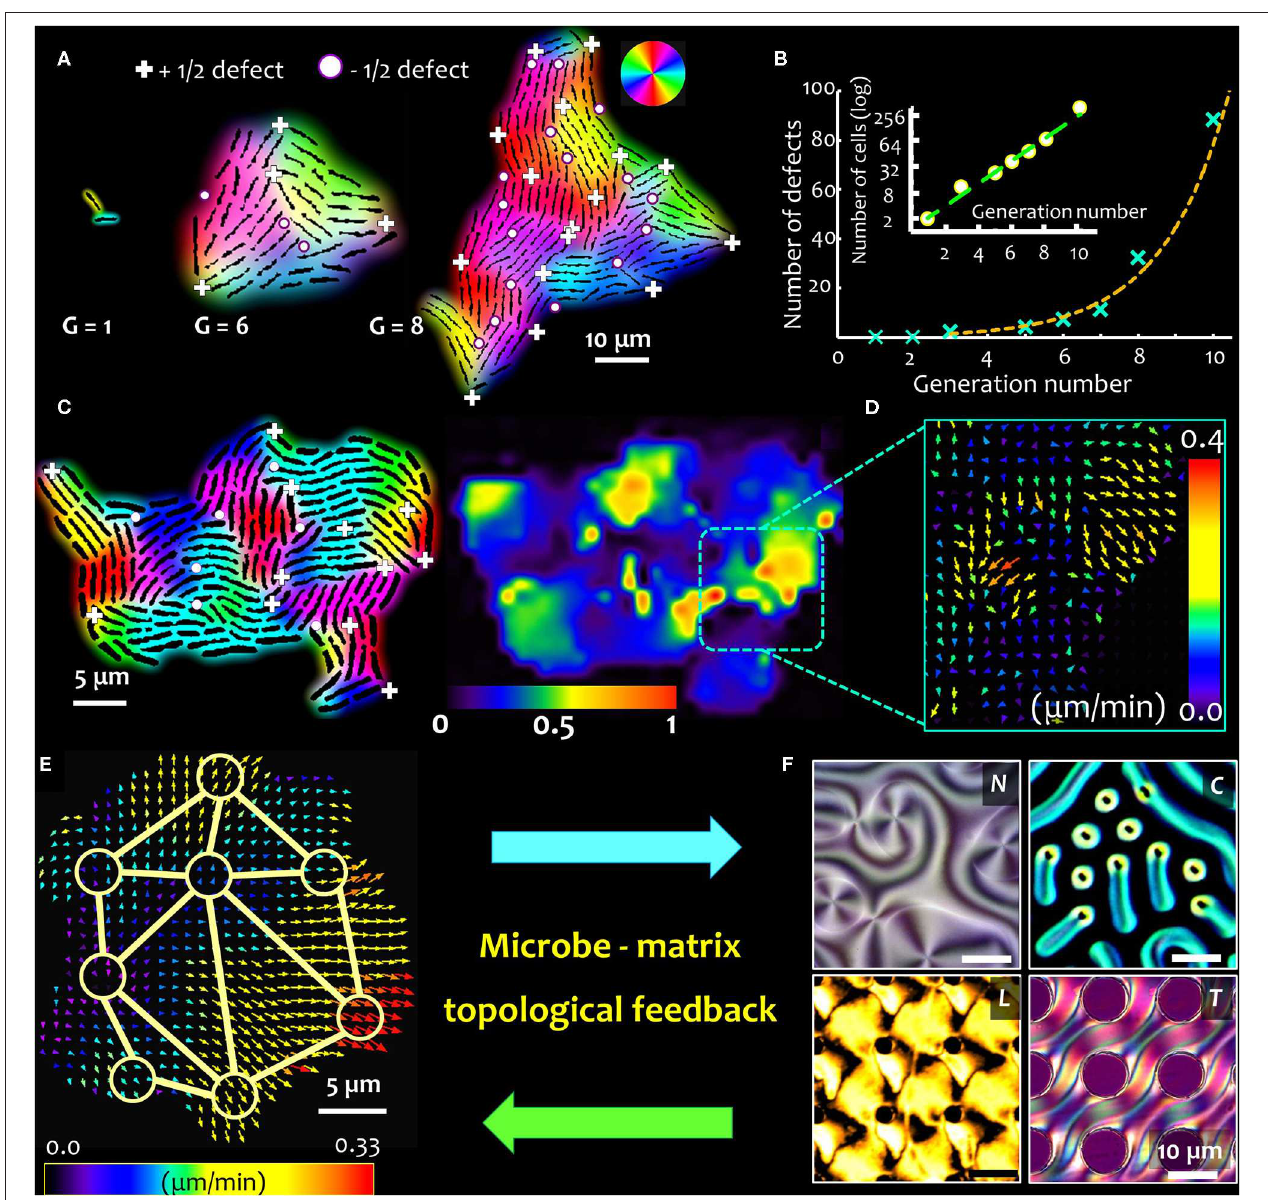
FIGURE 2 | Topological feedback in microbe-matrix ensemble. Close packing of microbes with anisotropic shape trigger spontaneous formation of topological defects. (A) Time lapse snapshots of a growing bacterial colony of non-motile E. coli strain (NCM 3722 delta-motA), where G refers to the generation time (i.e., the number of cell doubling events). Here the cells divide every ∼ 45min. As the colony expands, topological defects emerge spontaneously, either at the periphery or within the bulk of the colony. The defects nucleate at the intersection of 3 or more distinctly oriented microdomains, which are indicated here by ( + ) and (•) signs, for + 1/2 integer and − 1/2 integer topological strengths, respectively. (B) The total number of topological defects (sum of + 1/2 and − 1/2 integer defects) increases close to exponentially with time (represented here by the generation number, G), and near linearly to the corresponding cell number in the colony. The corresponding bacterial cell numbers are plotted on a log scale, in the inset. (C) As the cells keep dividing, the growth-induced mechanical stresses reorganize the topological defects within the colony, triggering active cell flows within the colony, revealing a patchy flow landscape with counter-rotating vortical regions. The relative strength of the active flows is indicated by the heat map scale bar. (D) The local active flow field, with the arrow-heads indicating the direction of the emergent flow, color coded according to the flow speed. Stronger flows are observed in regions with higher density of topological defects. (E) Topological defects overlaying active flow field couple with and the surrounding matrix (F) . The degree of order in the surrounding matrix, shown here for four distinct cases (clockwise)—nematic (N), cholesteric (C), and lyotropic liquid crystal materials (L), and a complex anisotropic substrate with topographical features (liquid crystal elastomers, T)—underpin the strength of the topological coupling. Stronger microbe-matrix coupling leads to higher feedback stability. Topological defect coupling, in combination with the growth induced mechanical stresses, introduce a novel biomechanical framework to analyze microbial physiology and behavior, both of which could be potentially tuned by the topology of the local